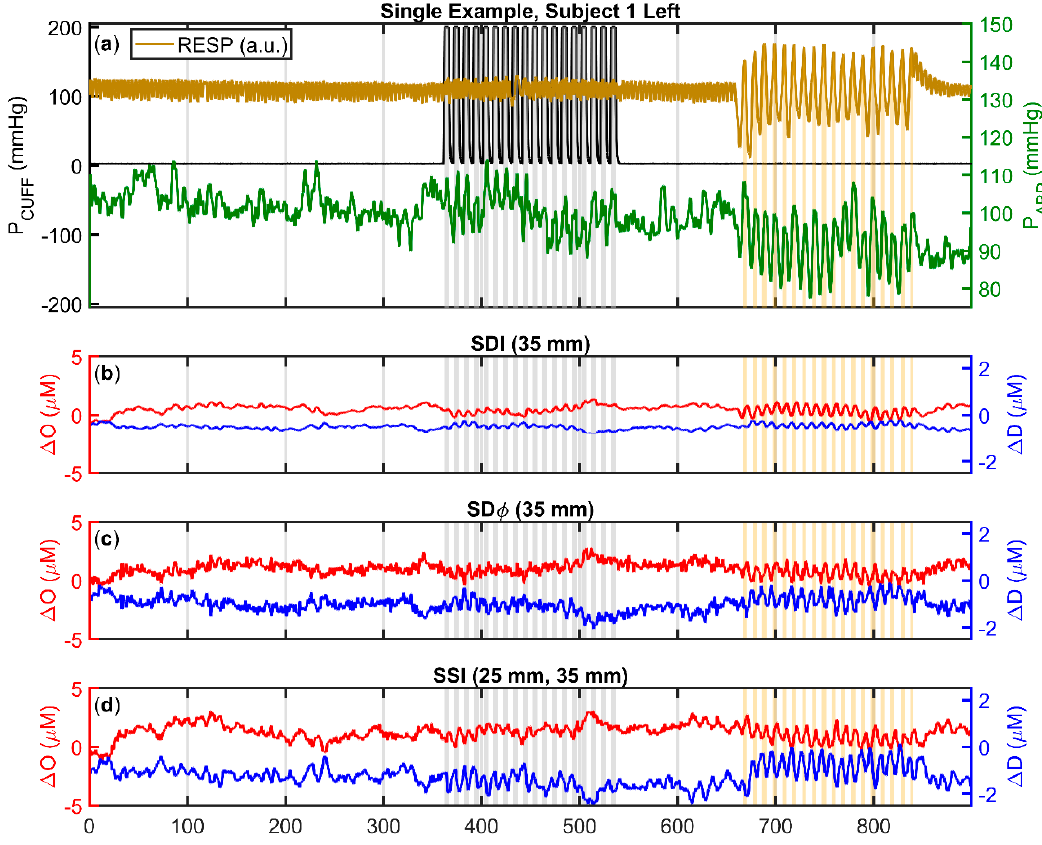
Figure 2. Example time (t) traces for experimental protocol. ( a ) Pneumatic cuff pressure (P CUFF , black), arterial blood pressure (ABP) (P ABP , green), respiration signal (RESP, mustard). ( b ) Changes in oxyhemoglobin ( Δ O , red, mean at 0.5 µM) and deoxyhemoglobin ( Δ D , blue, mean at − 0.5 µM) measured using single-distance intensity (SDI) with source 6 (35 mm, Figure 1b). ( c ) Changes in Δ O (red, mean at 1 µM) and Δ D (blue, mean at − 1 µM) measured using single-distance phase (SD ϕ ) with source 6 (35 mm, Figure 1b). ( d ) Changes in Δ O (red, mean at 1.25 µM) and Δ D (blue, mean at − 1.25 µM) measured using single-slope intensity (SSI) with sources 4 and 6 (25 mm and 35 mm, Figure 1b). Note: All traces are lowpass filtered to 0.2 Hz and shifted from zero baseline for visualization. The continuous wavelet transform (CWT) was used to find the phasor maps of Δ O , Δ D , Δ T , and ABP, which are indicated with bold-face phasor notation ( O , D , T , and ABP ). Next, the phasor ratio